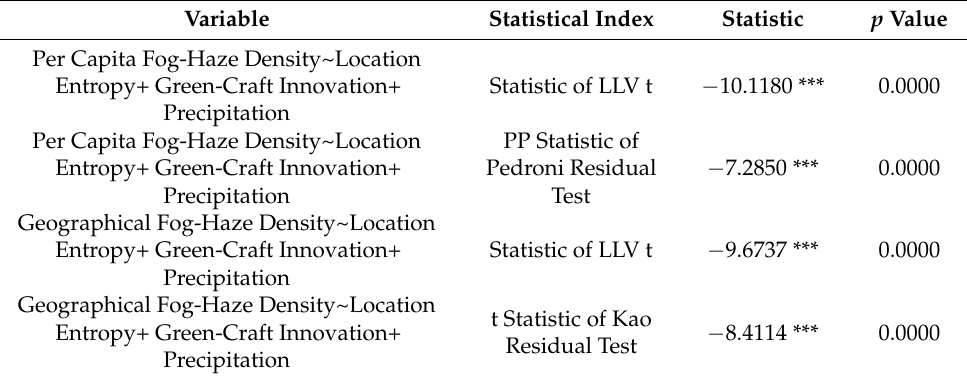
Table 5. Unit root test and cointegration test results of panel